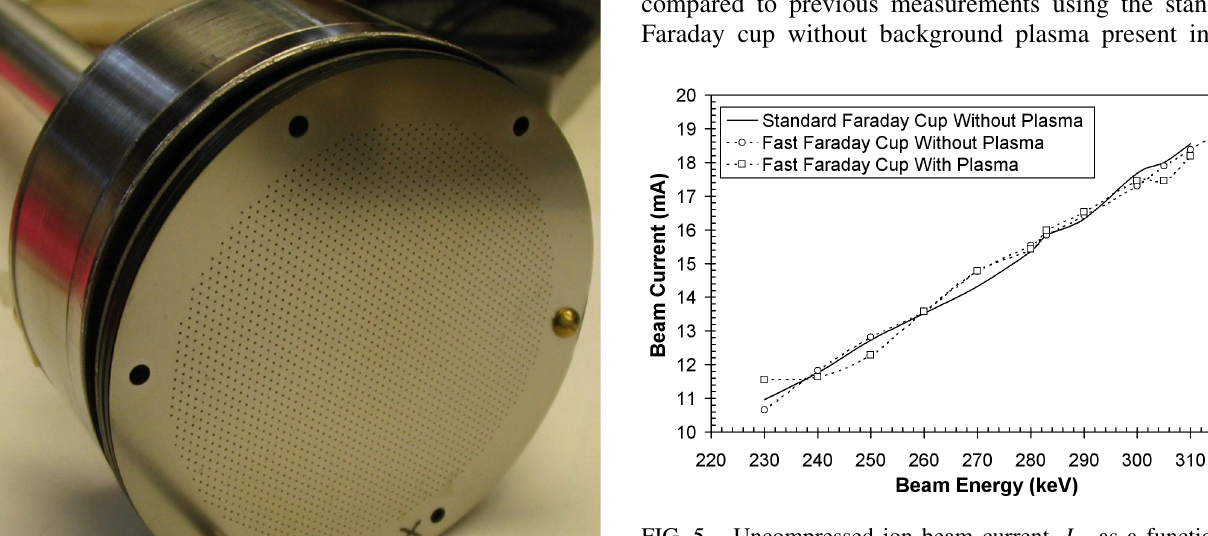
, as a function of b